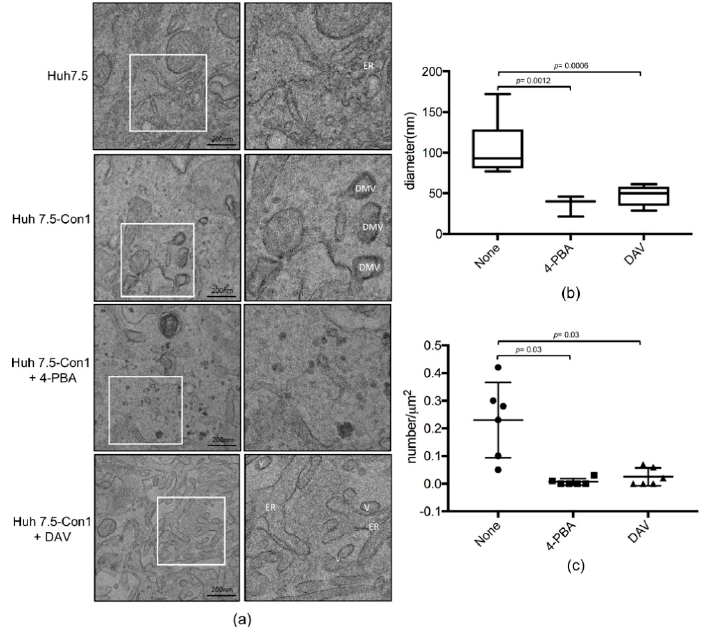
(Figure S2.). MMVs appeared at late stages of infection as a result of stress or autophagy [18]. The results of our electron microscopy analysis suggested that 4-PBA interfered with HCV replication by preventing DMV formation.